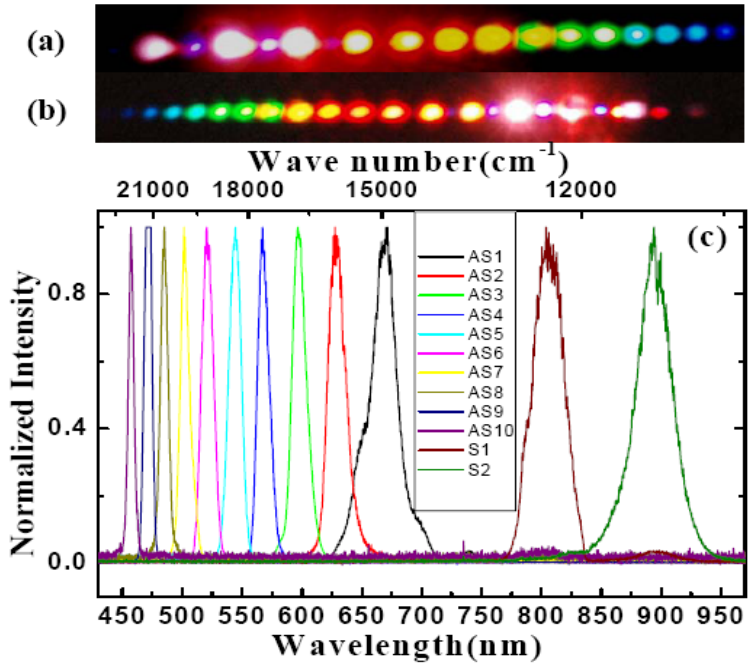
Figure 19. Photograph of the sidebands in a white sheet of paper behind the BBO crystal when (a) beam1 works as a pump. (b) beam2 works as a pump. (c) Spectra of